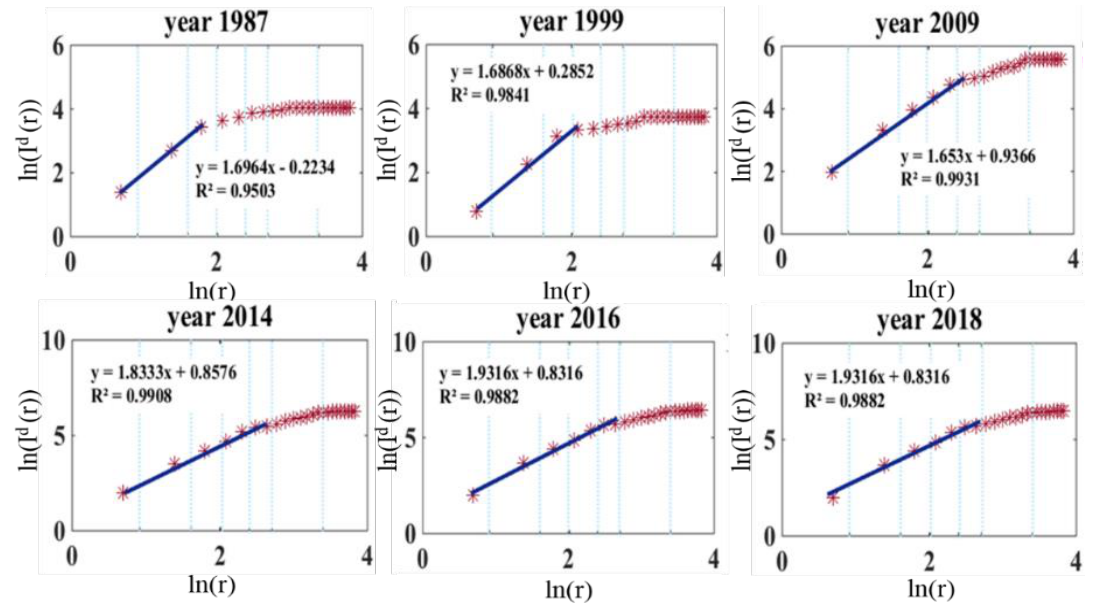
Figure 7. Interstation distance for select years.